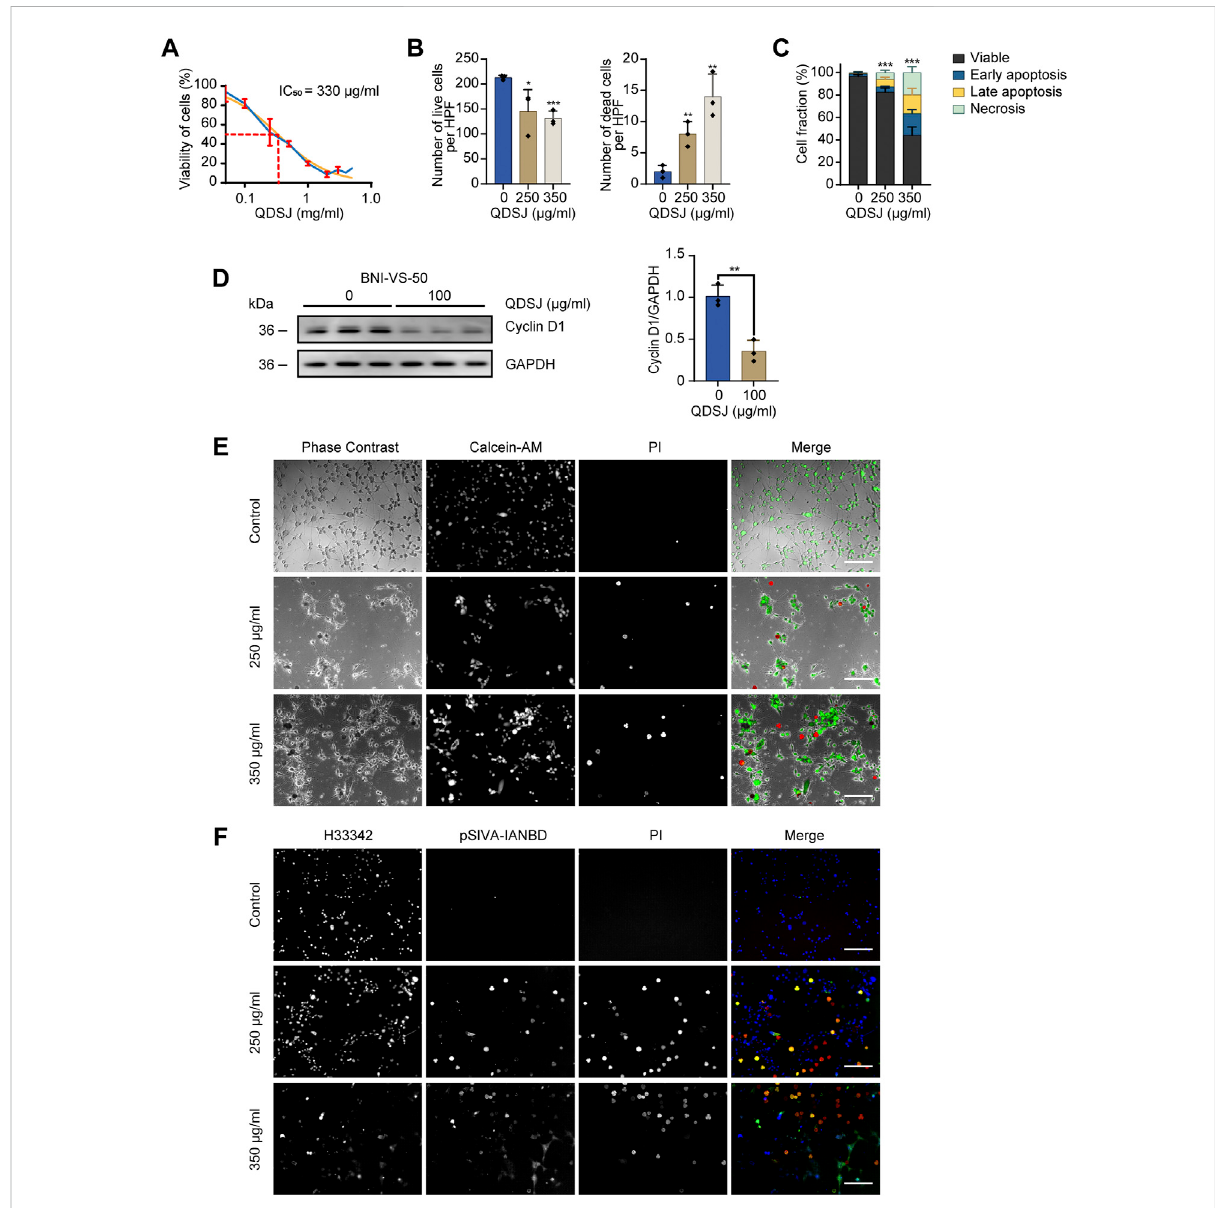
FIGURE 3 QDSJ decoction induces necrotic cell death and apoptosis in schwannoma cells. (A) Dose-response curve of BNI-VS-50 cells treated with freeze-dried QDSJ powder reconstituted in PBS for 72 h. The blue curve represents the experimental data. The orange curve shows the regression curve. IC 50 =330 μ g/ml. (B) Numbers of live and dead BNI-VS-50 cells determined by Calcein-AM/PI staining 48 h after QDSJ treatment. (C) Percentage of apoptotic and necrotic BNI-VS-50 cells determined by pSIVA-IANBD/PI staining at 48 h after QDSJ treatment. (D) Representative blot and quantitative analysis of band optical densities for Cyclin D1 and GAPDH (loading control) from BNI-VS-50 cells collected 48 h after QDSJ treatment. (E) Representative images of Calcein-AM/PI staining. Living cells appeared green (Calcein-AM positive) and the nuclei of dead cells emitted red fl uorescence (PI positive). (F) Representative images of pSIVA-IANBD/PI staining. pSIVA-IANBD negative/PI negative: viable; pSIVA-IANBD positive/PI negative: early apoptosis; pSIVA-IANBD positive/PI positive: late apoptosis; pSIVA-IANBD negative/PI positive: necrosis. Scalebar=200 μ m; n =3/group;means±SDs;* p < 0.05,** p < 0.01,and*** p < 0.001comparedtothecontrolgroupbyANOVAfollowedbyTukey ’ s post hoc-test (B) , 3-way ANOVA (C) , and Student ’ s t test (D) . HPF: high-power fi